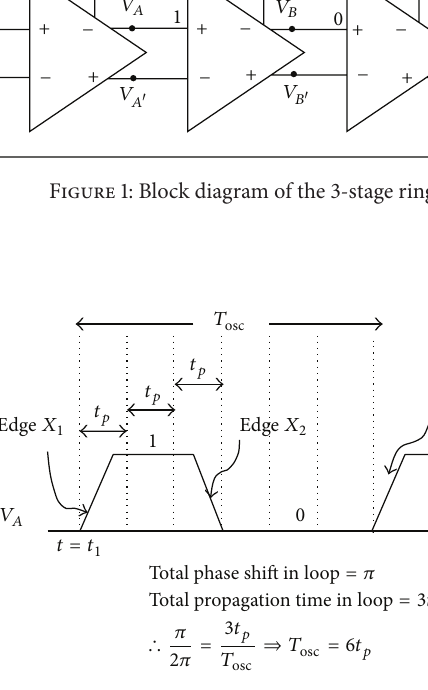
Figure 2: Corresponding waveform of the 3-stage ring-VCO and total period